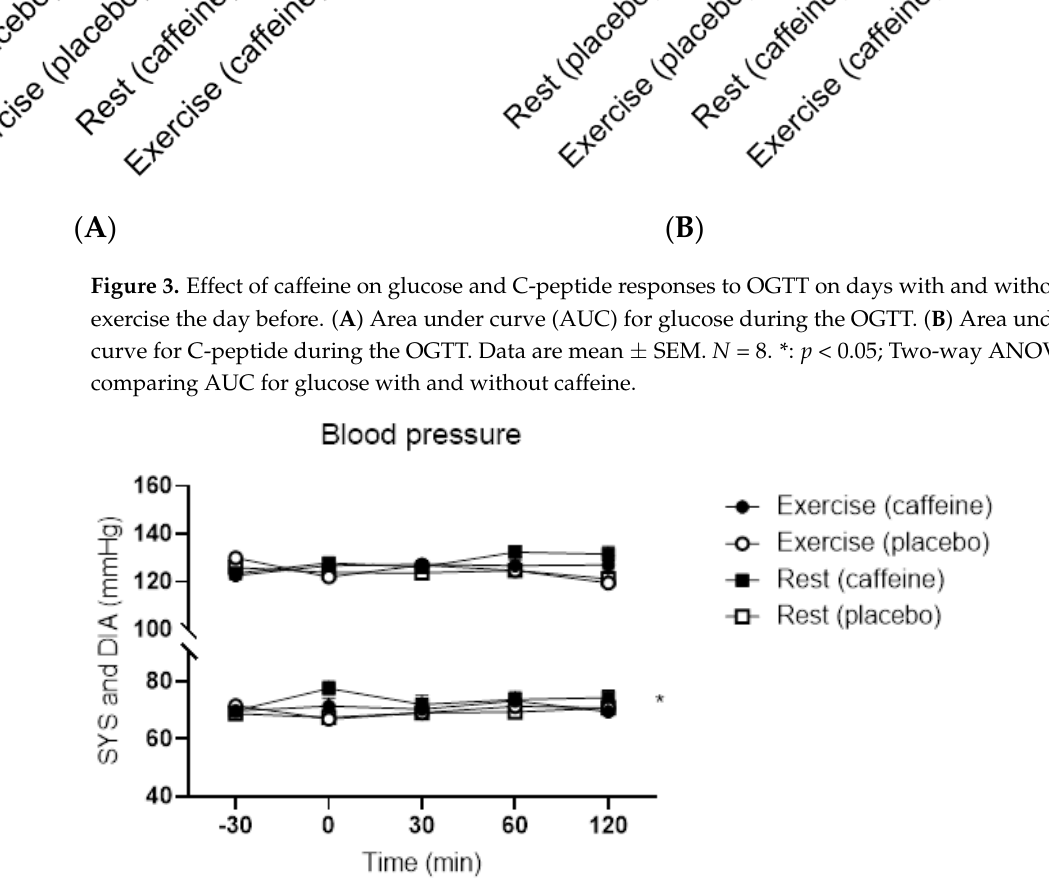
Figure 3. Effect of caffeine on glucose and C-peptide responses to OGTT on days with and without exercise the day before. ( A ) Area under curve (AUC) for glucose during the OGTT. ( B ) Area under curve for C-peptide during the OGTT. Data are mean ± SEM. N = 8. *: p < 0.05; Two-way ANOVA comparing AUC for glucose with and without caffeine.